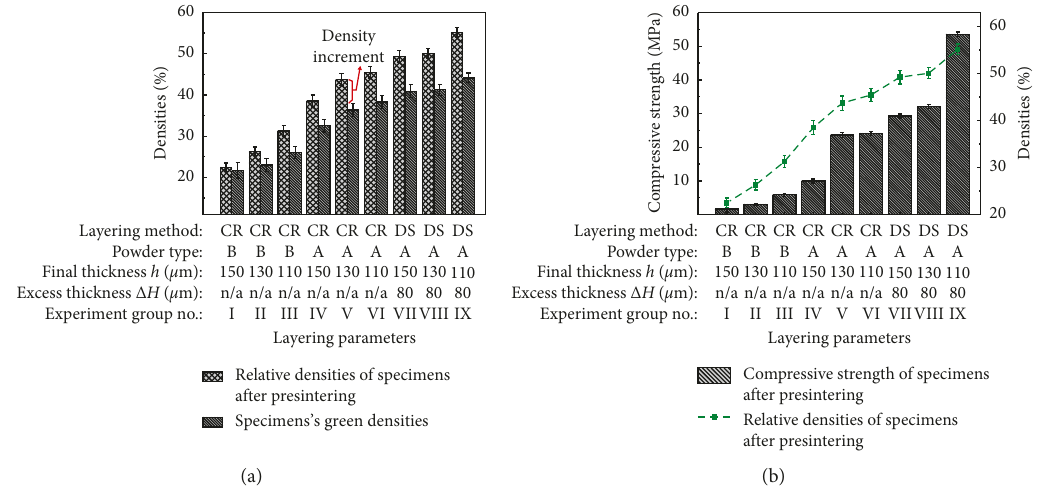
Figure 13: (a) Variations of presintered specimens’ densities along with their initial densities. (b) Variations of presintered specimens’ compressive strength along with their densities after presintering.